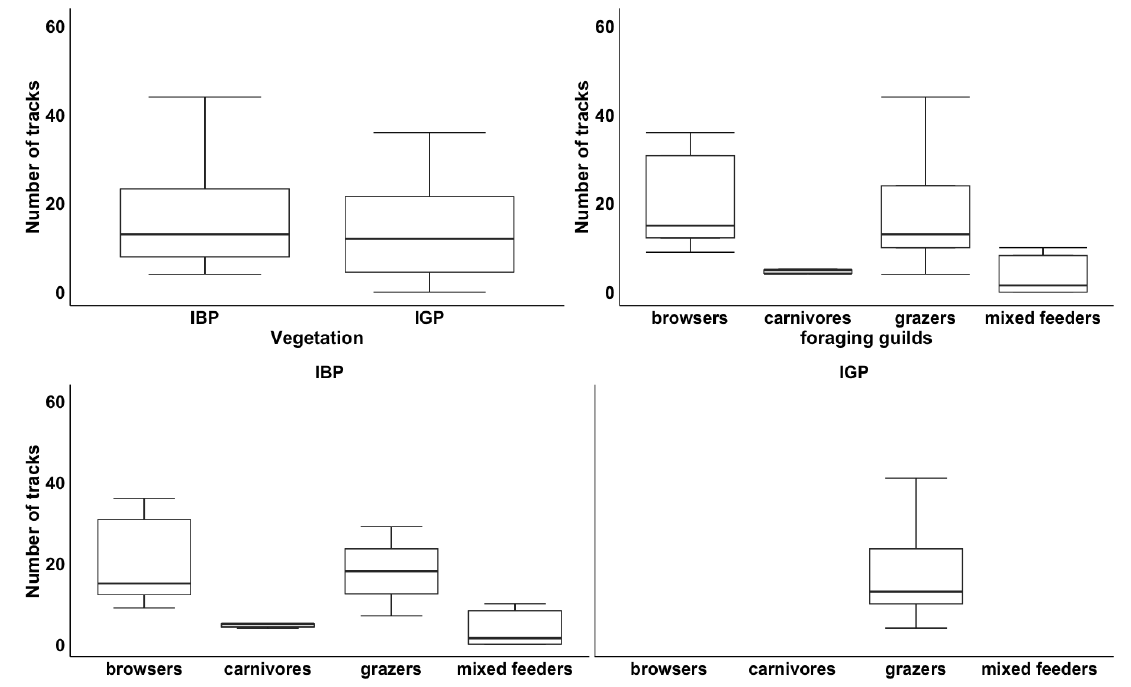
Figure 4. Frequency of occurrence of the number of tracks per treatment by vegetation type (top left), foraging guilds for both vegetation types (top right), and the interaction between vegetation and foraging guilds, bottom two plots (IBP = Indigenous bush-dominated plots, IGP = Indigenous grass- dominated plots). Boxes show medians (solid black line across the box) and 1st and 3rd quartiles. Table 4. The output of a generalized linear mixed model fitted by a maximum likelihood (Laplace Approximation) showing treatment types and vegetation type. Significant values are indicated by an asterisk.